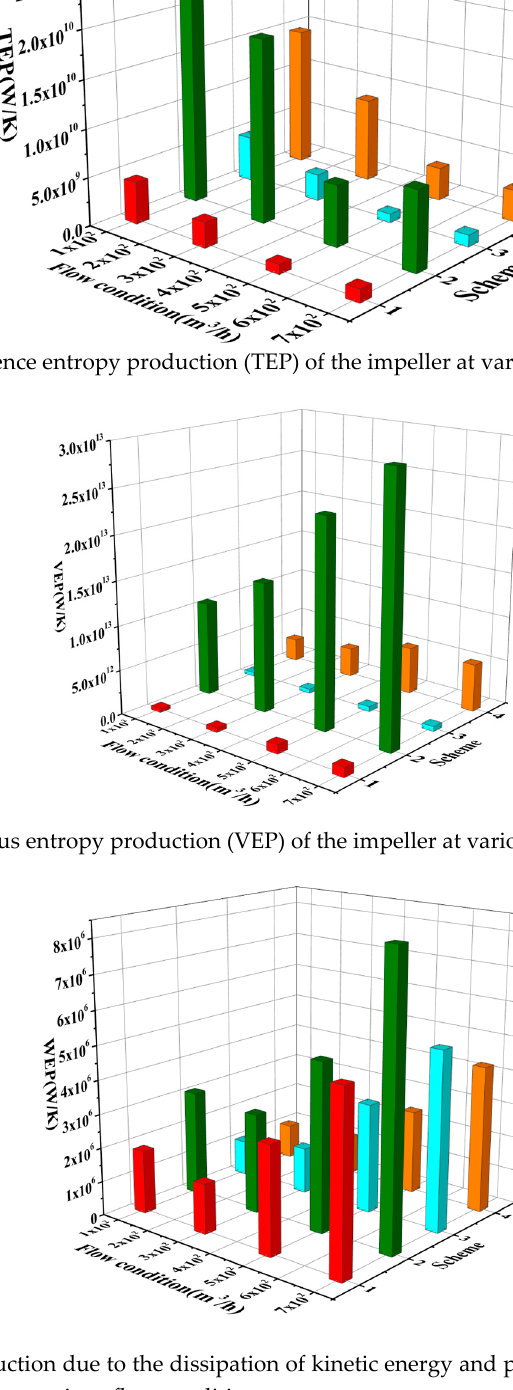
Figure 13. Impeller entropy production at various flow conditions.